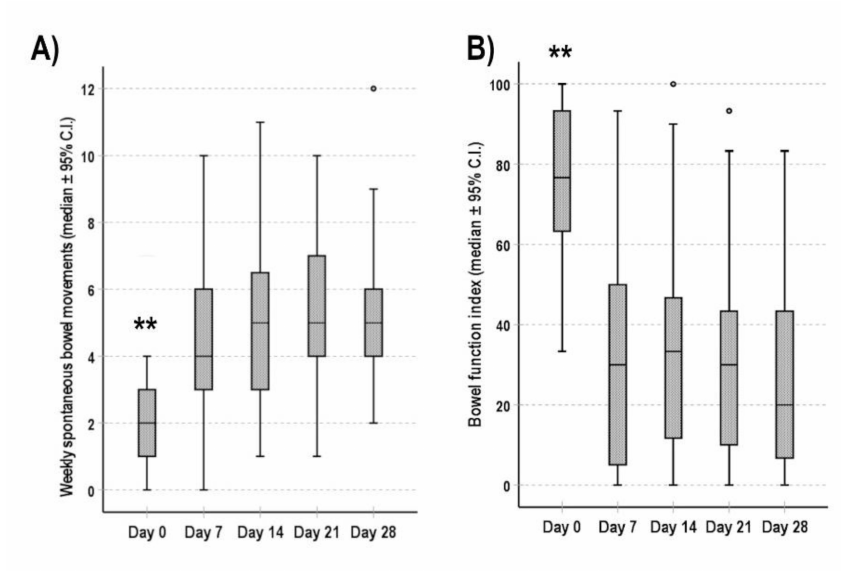
Figure 3. Evolution of bowel function during the 4 weeks of follow up. ( A ) Number of weekly spontaneous bowel movements, ( B ) BFI score. Data are shown as median (95% C.I.). ** p < 0.001 for the comparisons between values at day 0 and values at day 7, 14, 21 and 28.